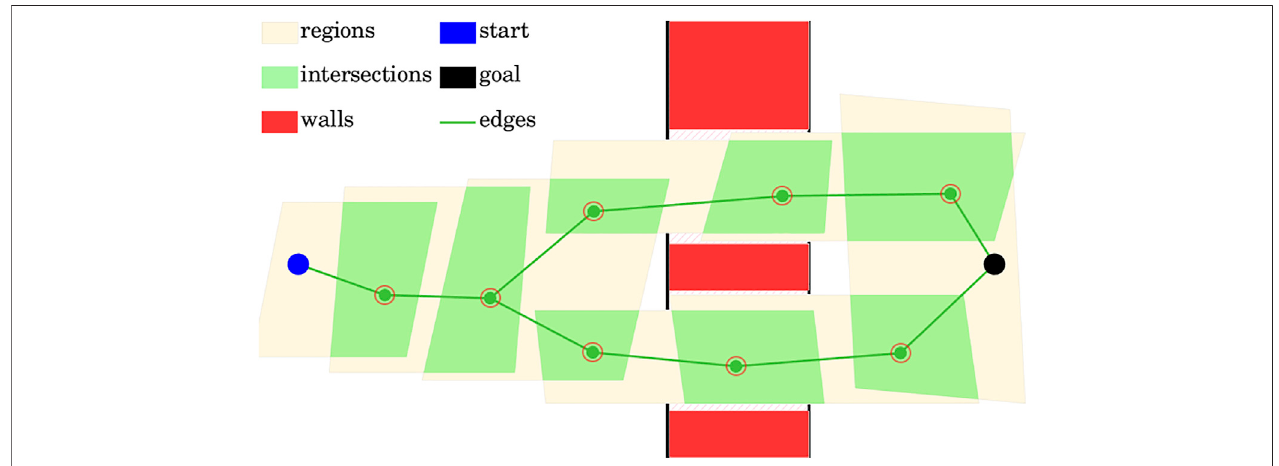
FIGURE 3 | Graph representation of the path, based on obstacle-free region